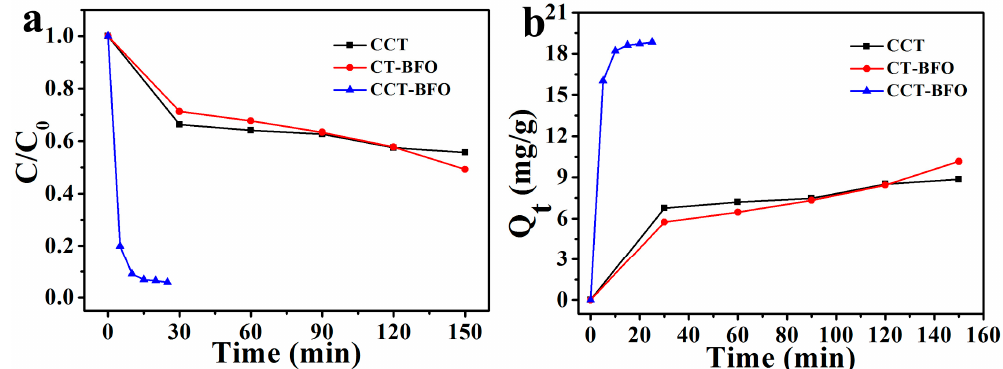
Figure 7. ( a ) Changes of the relative concentrations of MB aqueous solutions, added by different adsorbents, versus time; ( b ) Changes of the adsorption capacities of three adsorbents versus